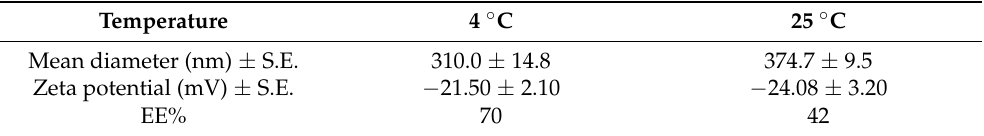
Table 9. Mean diameter, Zeta potential, and EE% of HA-NP-CTAB-H 2 S-DOXO after 72 h of storage at 4 ◦ C and at controlled room temperature (25 ◦